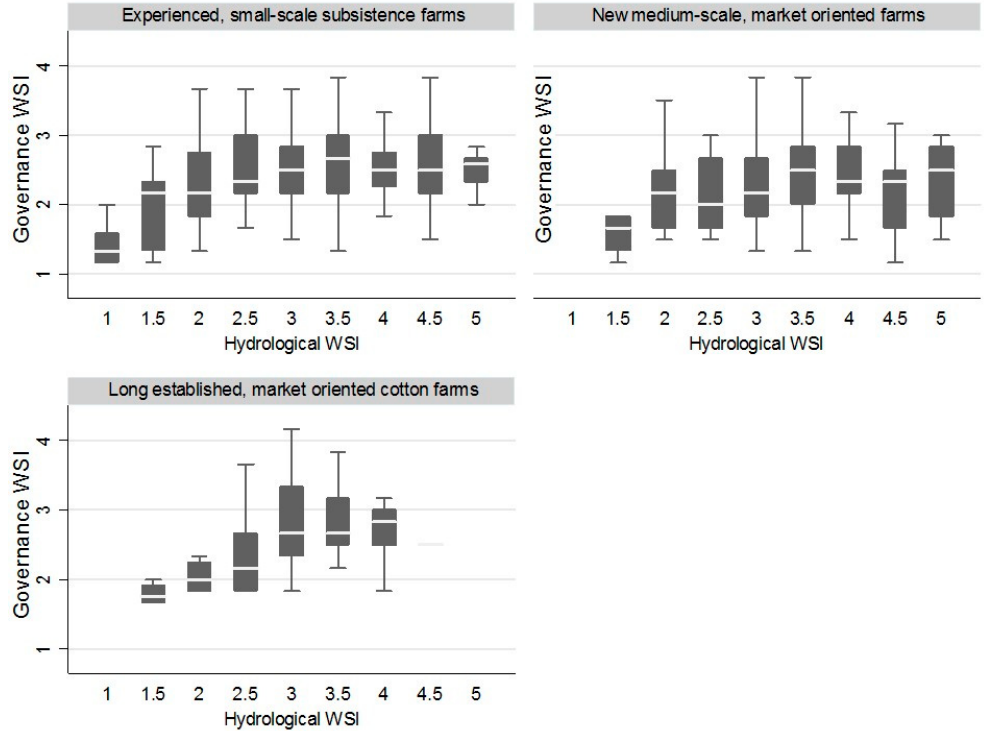
Figure 4. Boxplot of hydrology and governance dimensions across farm types. Source: Survey Data 2013.